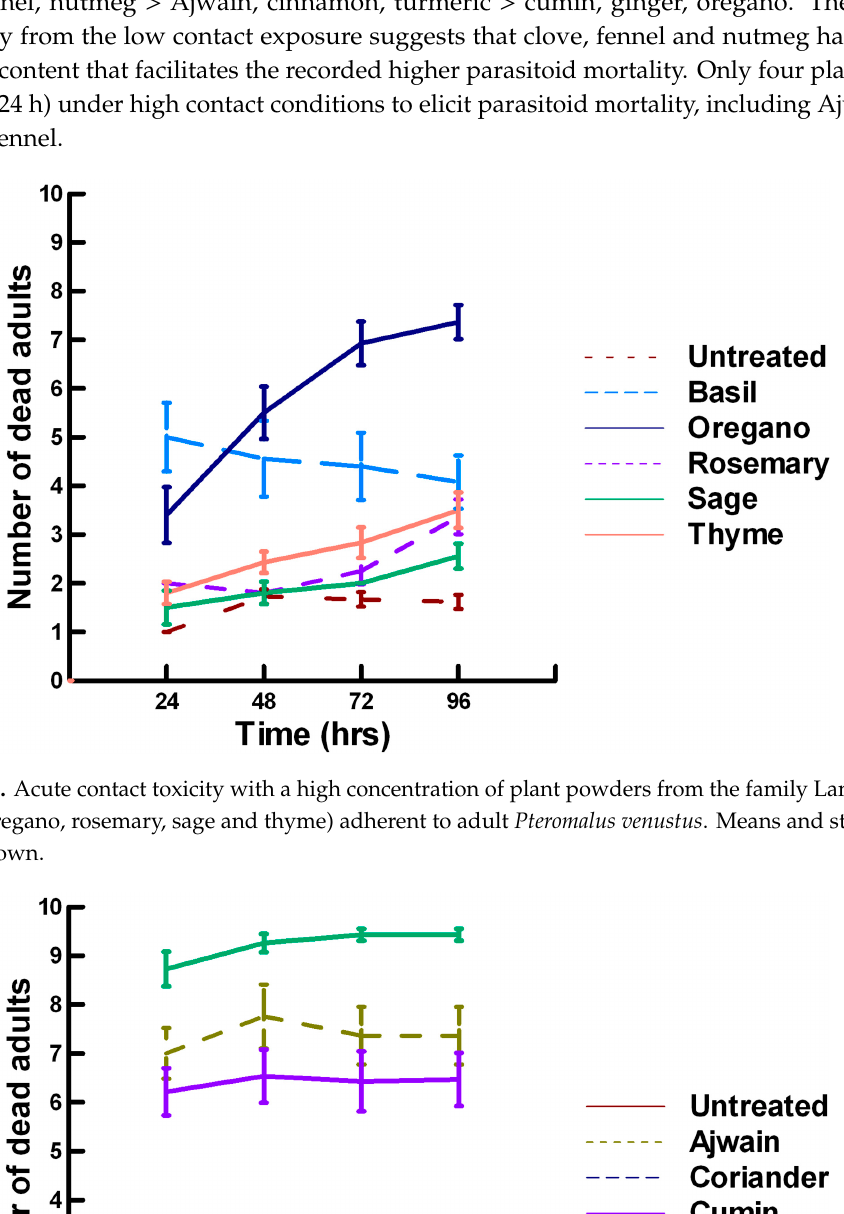
Figure 6. Acute contact toxicity with a high concentration of plant powders from the families Lauraceae (cinnamon), Myrtaceae (clove), Fabaceae (Fenugreek), Myristicaceae (nutmeg) and Zingiberaceae (ginger, turmeric) adherent to adult Pteromalus venustus . Means and standard error shown.